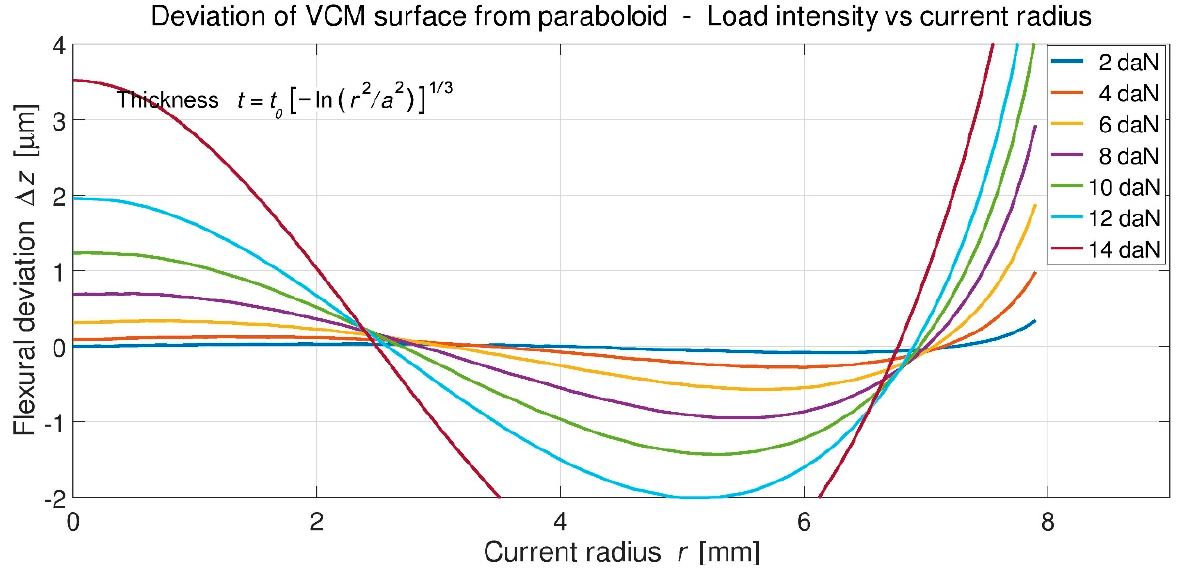
Figure 8. Least mean ‐ square flexural deviations. Conical shape for 0.90 < ρ < 1. t (1) = 120 μ m. Collarette 20 μ m width.